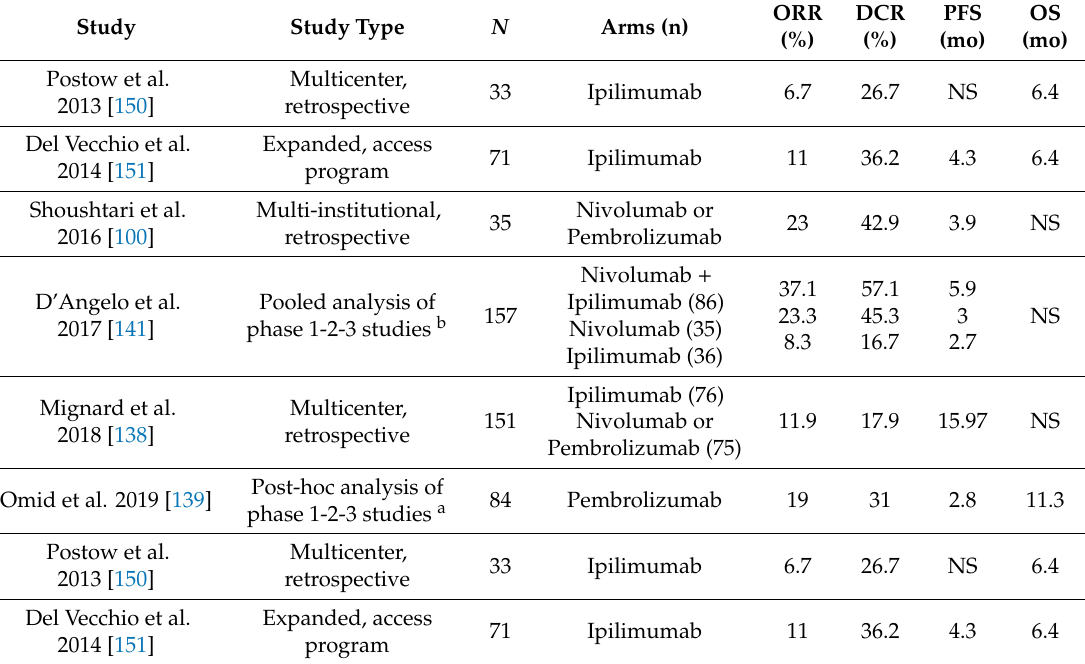
Table 3. Selected studies that assessed immunotherapy in advanced mucosal